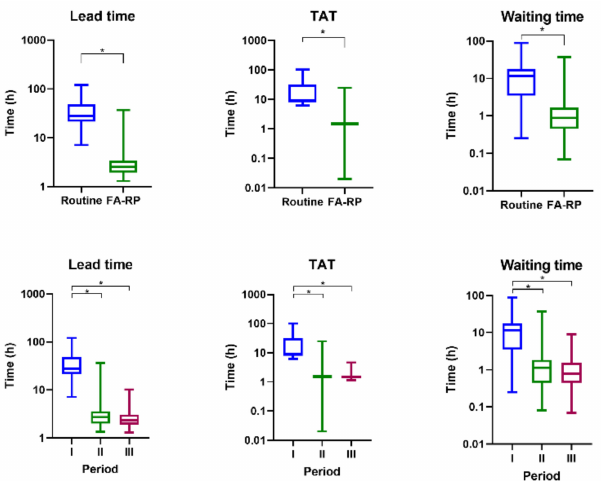
Figure 3. Comparison of test time according to the multiplex polymerase chain reaction (mPCR) test and period; * means two values were statistically significant ( p < 0.05).